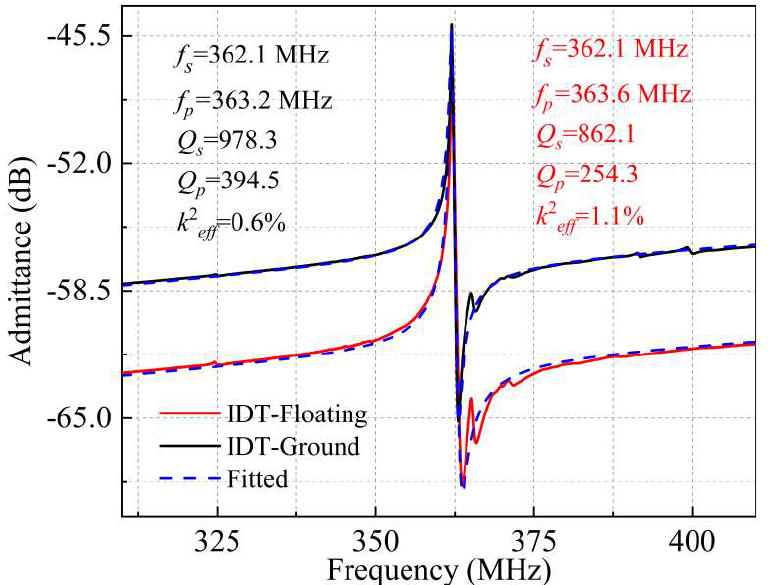
Figure 10. The measured and fitted admittance curves of LWRs using Au as the top electrode material with the extended lateral reflection boundary width of 12 μm.